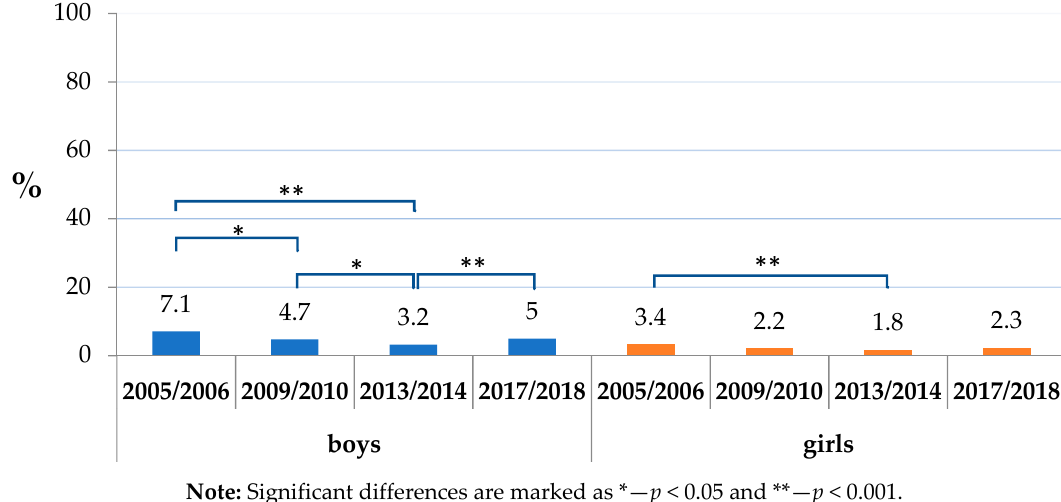
Figure 3. Toothbrushing less than once a day and the consumption of sweets or sweetened soft drinks by sex.